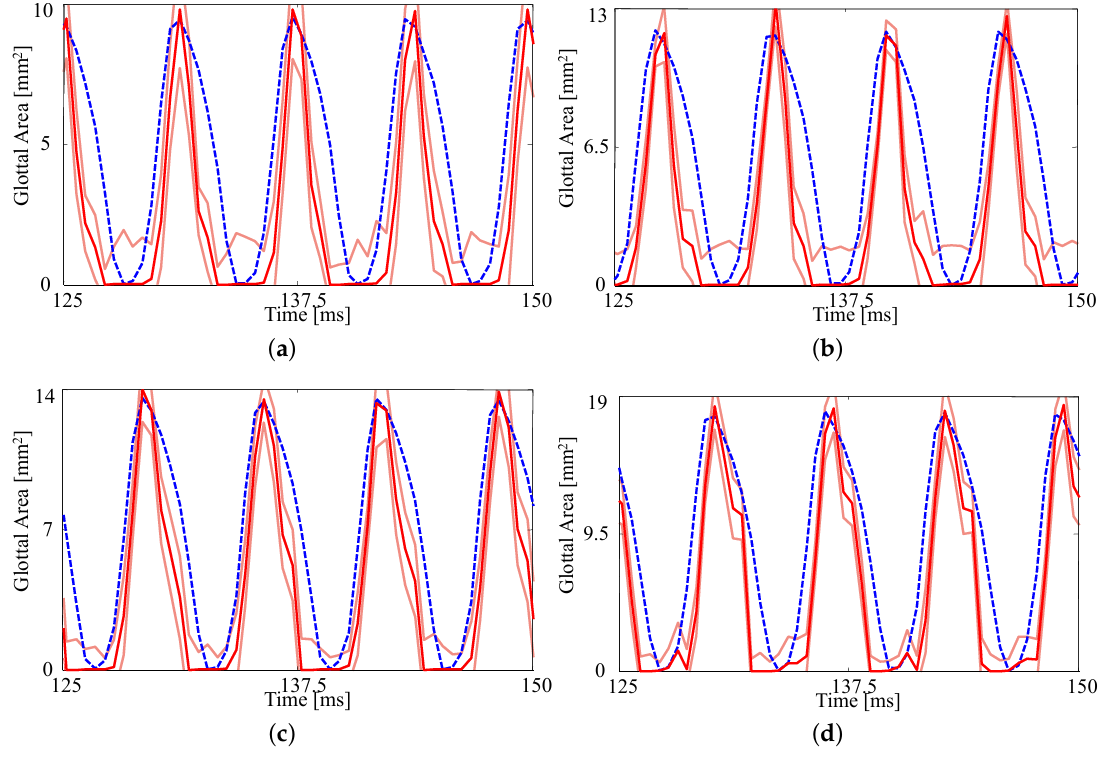
Figure 6. Comparison on the glottal area waveforms extracted from HSV and the FE predictions from the fitted material properties for ( a ) p sub = 0.91, kPa ( b ) p sub = 1.00kPa, ( c ) p sub = 1.09kPa, and ( d ) p sub = 1.18kPa. Blue dashed line: HSV; red solid line: FE model; orange solid lines: uncertainty bounds from the FE estimate.